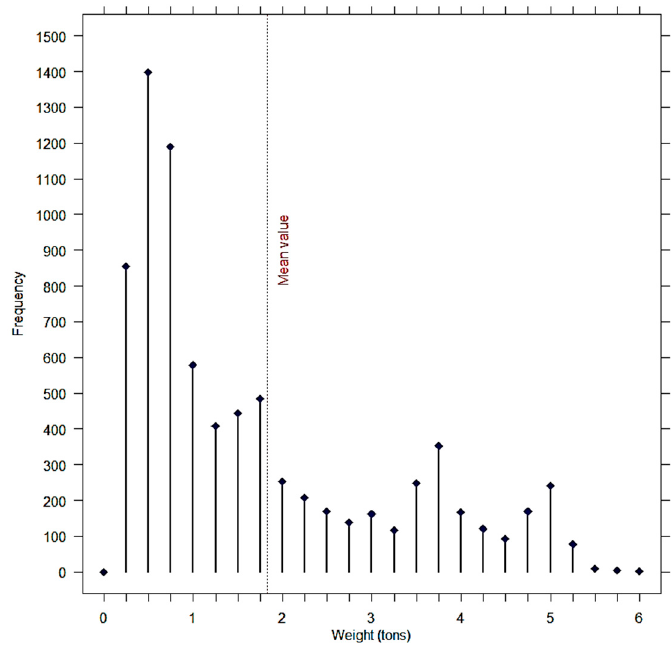
Figure 7. Distribution of the operation’s weights.